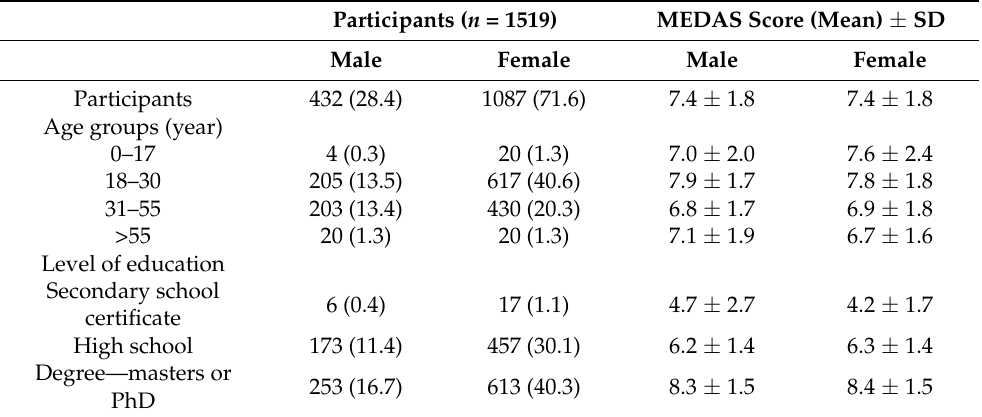
Table 1. General characteristics of the study population and Mediterranean Diet Adherence Screener (MEDAS) score by